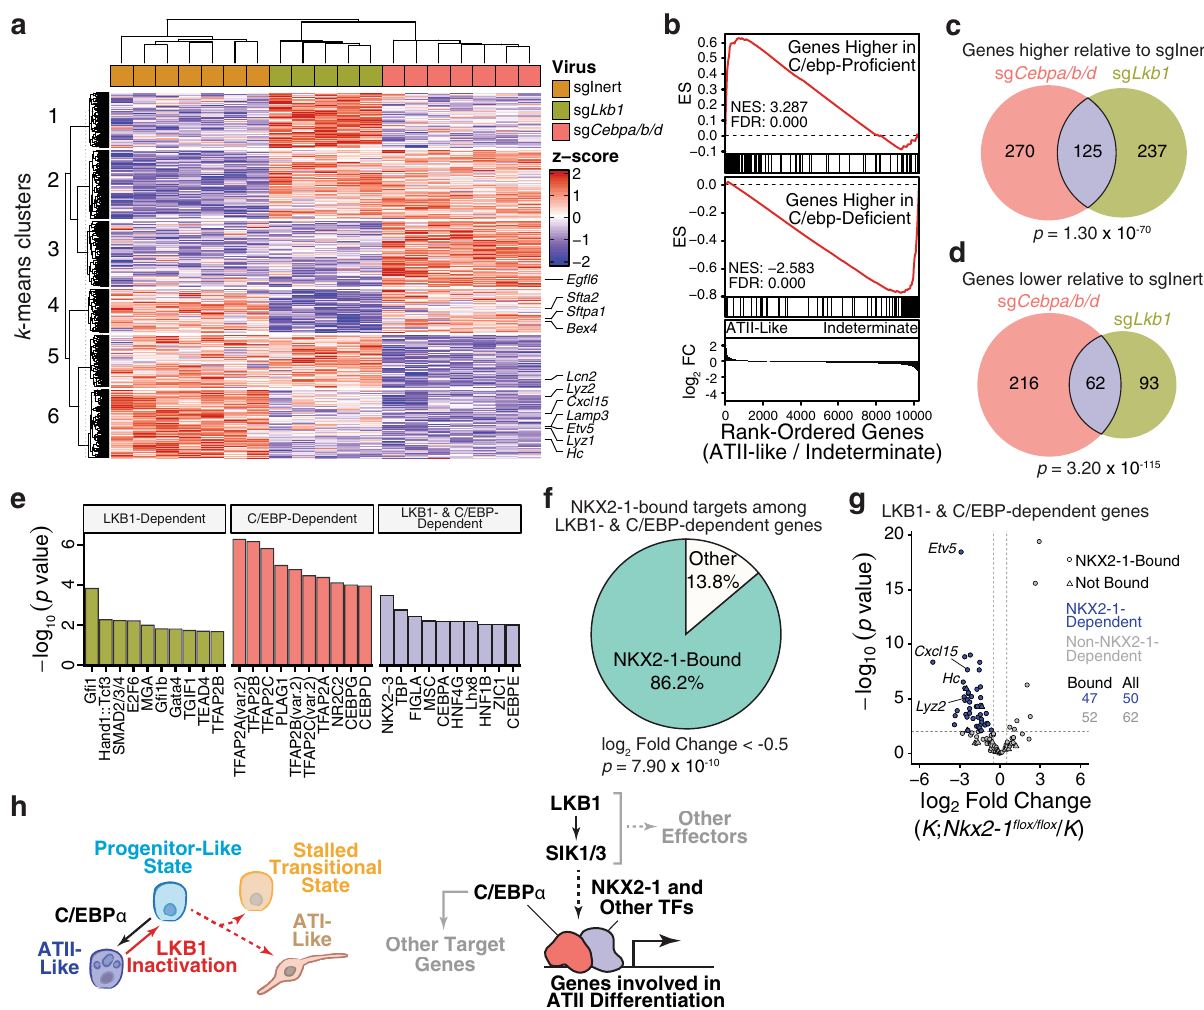
Fig. 6 C/EBP transcription factors co-regulate a subset of LKB1-dependent genes. a Transcriptional pro fi ling of Lkb1 - and C/ebp-targeted tumors as well as oncogenic KRAS-only tumors (sgInert). Genes that vary signi fi cantly (FDR < 0.05; likelihood ratio test). Markers of alveolar type II identity are indicated. b Enrichment of C/EBP-dependent genes (top) among genes that are higher in the ATII-like state. Enrichment of genes that are higher in C/ebp-targeted tumors (bottom) among genes that are higher in the indeterminate state. ES Running enrichment score. NES normalized enrichment score, FC fold change. c , d Comparison of genes that are higher ( c ) or lower ( d ; absolute log 2 Fold Change >1 and FDR < 0.05) in Lkb1 - or C/ebp-targeted tumors relative to tumors driven by oncogenic KRAS alone (sgInert). P values from hypergeometric tests are indicated. e Transcription factor motif enrichment on genes that are either uniquely lower (log 2 Fold Change < − 1 and FDR < 0.05) in Lkb1 - (left) or C/ebp-targeted tumors (middle) relative to sgInert tumors or are jointly LKB1- and C/EBP-dependent (right). f Proportion of genes proximal to NKX2-1 binding sites (within − 3 to + 1 kb from TSS) among those that are jointly dependent upon LKB1 and C/EBPs (log 2 Fold Change < − 0.5 and FDR < 0.05). P value from hypergeometric test is indicated. Derived from previously published NKX2-1 ChIP-seq dataset 85 . g Transcriptional comparison of Nkx2-1 -de fi cient and Nkx2-1 -pro fi cient lung tumors using previously published gene expression data 86 . Genes that are jointly dependent upon LKB1 and C/EBPs (log 2 Fold Change < − 0.5 and FDR < 0.05) are plotted. Blue fi ll denotes genes that are dependent upon NKX2-1(log 2 Fold Change < − 0.5 and FDR < 0.05). Shape indicates proximal binding of NKX2-1 (within − 3 to + 1 kb from TSS). The number of NKX2-1-bound genes that are or are not NKX2-1-dependent is indicated. h Proposed model for the function of LKB1 in lung tumors. Lkb1 inactivation enables the emergence of neoplastic cell states outside of ATII-like identity. Upon Lkb1 restoration, progenitor-like cells assume a more mature, less proliferative ATII-like identity, re fl ecting the increased activity of the lineage-de fi ning factor, C/EBP α (left). At the molecular level (right), C/EBP operates indirectly downstream of LKB1-SIK in cooperation with NKX2-1 and other transcription factors to drive ATII